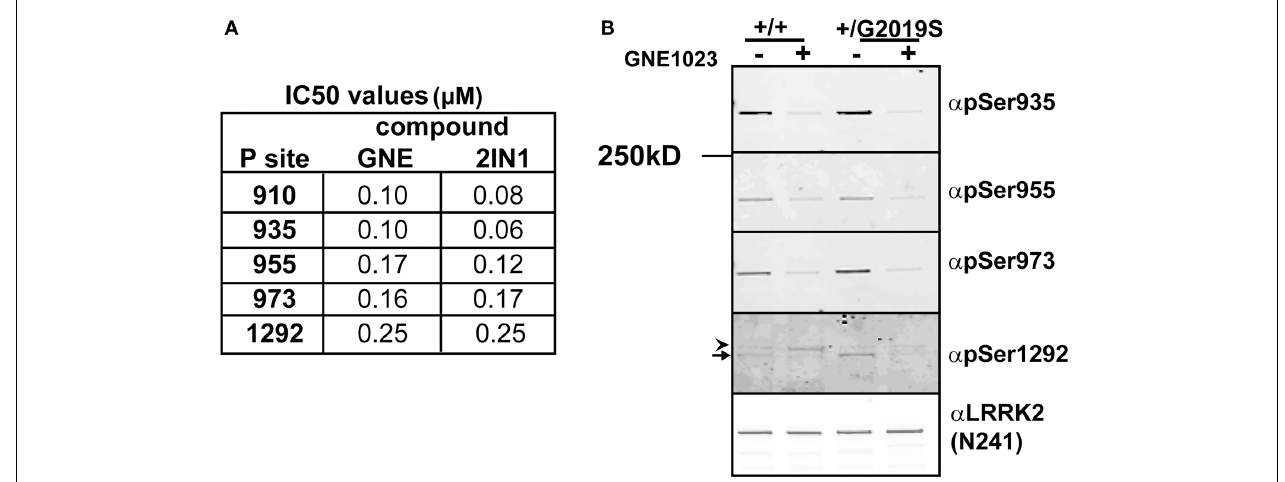
FIGURE 3 | Comparative analysis of inhibitor induced dephosphorylation for Ser1292 and cellular phosphorylation sites after kinase inhibition. (A) HEK 293 T-REx cells stably expressing GFP-LRRK2-Gly2019Ser were treated with DMSO or increasing concentrations of GNE1023 or LRRK2-IN1 for 90min. Cell lysates were co-immunoblotted for GFP and anti-phospho-Ser935 ( α pS935), anti-phospho-Ser955 ( α pS955), anti-phospho-Ser973 ( α p973), anti-phospho-Ser1292 ( α pS1292). IC 50 values were calculated using